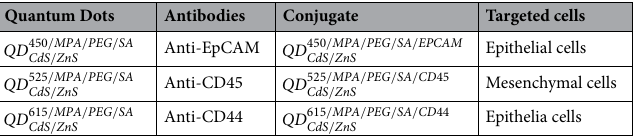
Table 1. Quantum dots coupled with antibodies, based on the requirement of the targeted